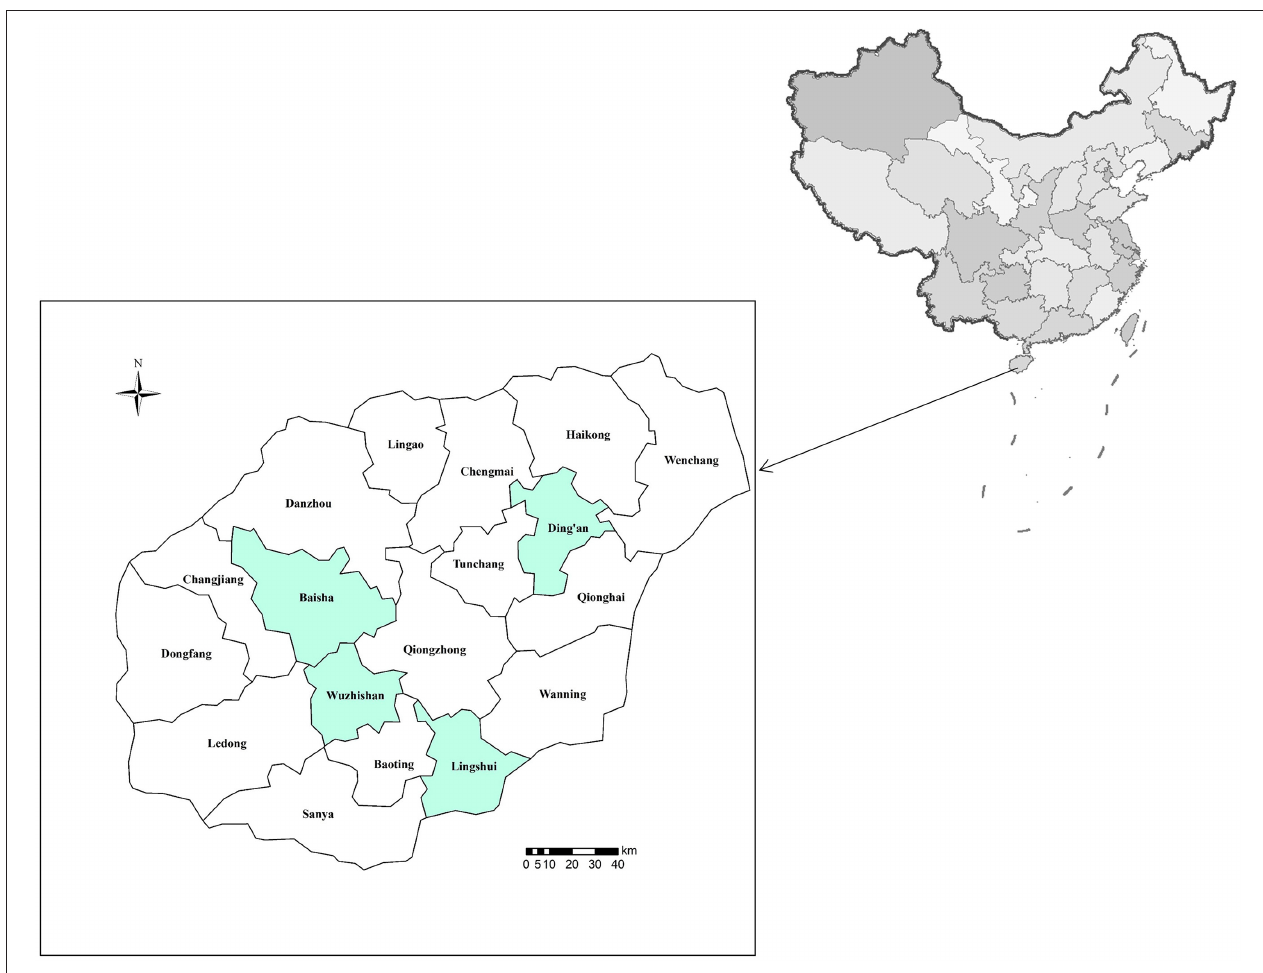
FIGURE 1 | The colored locations where samples were